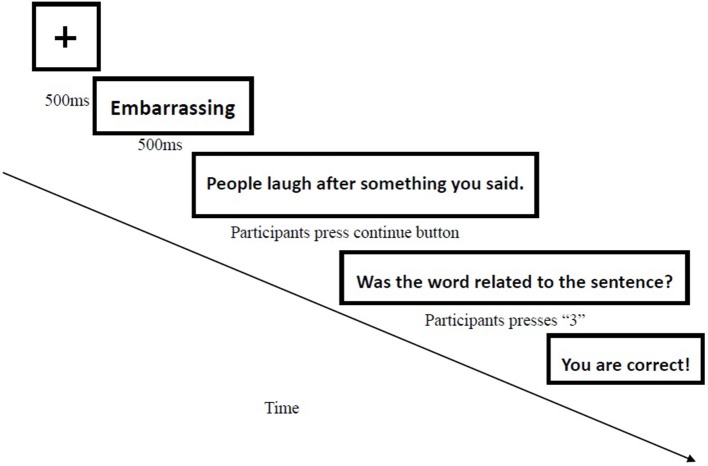
Example of a single trial in the WSAP interpretation bias assessment.